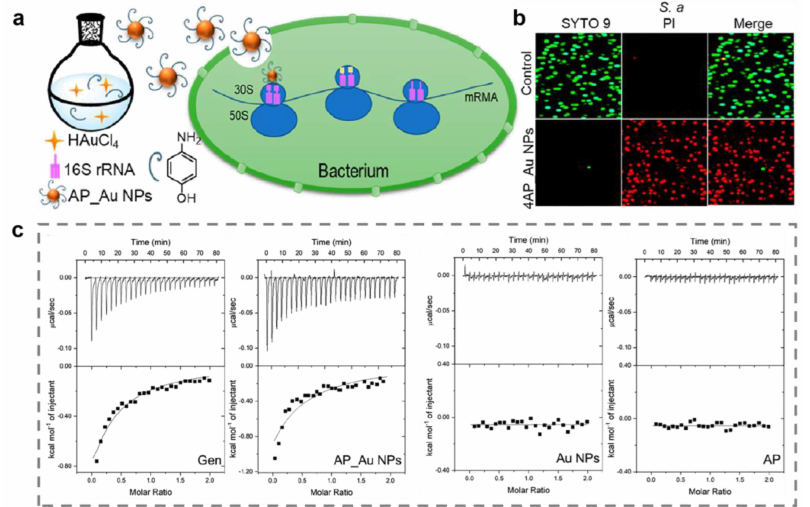
Figure 5. Protein destruction by aminophenol (AP)-modified gold nanoparticles (AP_Au NPs). ( a ) The antibacterial mechanism of AP_Au NPs. ( b ) Evaluation of live-dead staining of bacteria. ( c ) Isothermal titration calorimetry analysis of the interface between different agents and bacterial 16S rRNA. Reprinted with permission from Ref. [81]. Copyright 2022 American Chemical